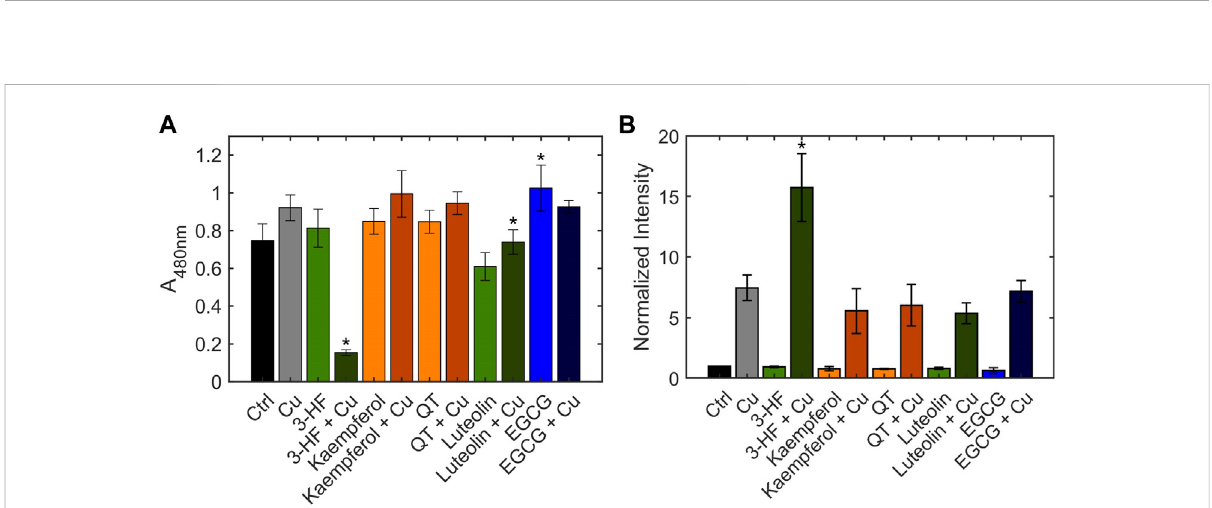
FIGURE 9 (A) Cell viability of HepG2 cells in the presence and absence of fl avonoids and Cu(II), measured using the MTS assay. HepG2 cells were stimulated with 20 μ M fl avonoid with or without 50 μ M CuSO 4 . The MTS reagent was added after 24 h. After 1 h incubation with the reagent, absorbancewasmeasuredat490 nm. (B) Quanti fi cationoftotalcellularcopperofHepG2cellsinthepresenceandabsenceof fl avonoidsandCu(II), measuredbyICP-OES.HepG2cellswerestimulatedwith20 μ M fl avonoidwithorwithout50 μ MCuSO 4 for24 h.ErrorbarsrepresentSD, n =3. * p < 0.05 versus the vehicle